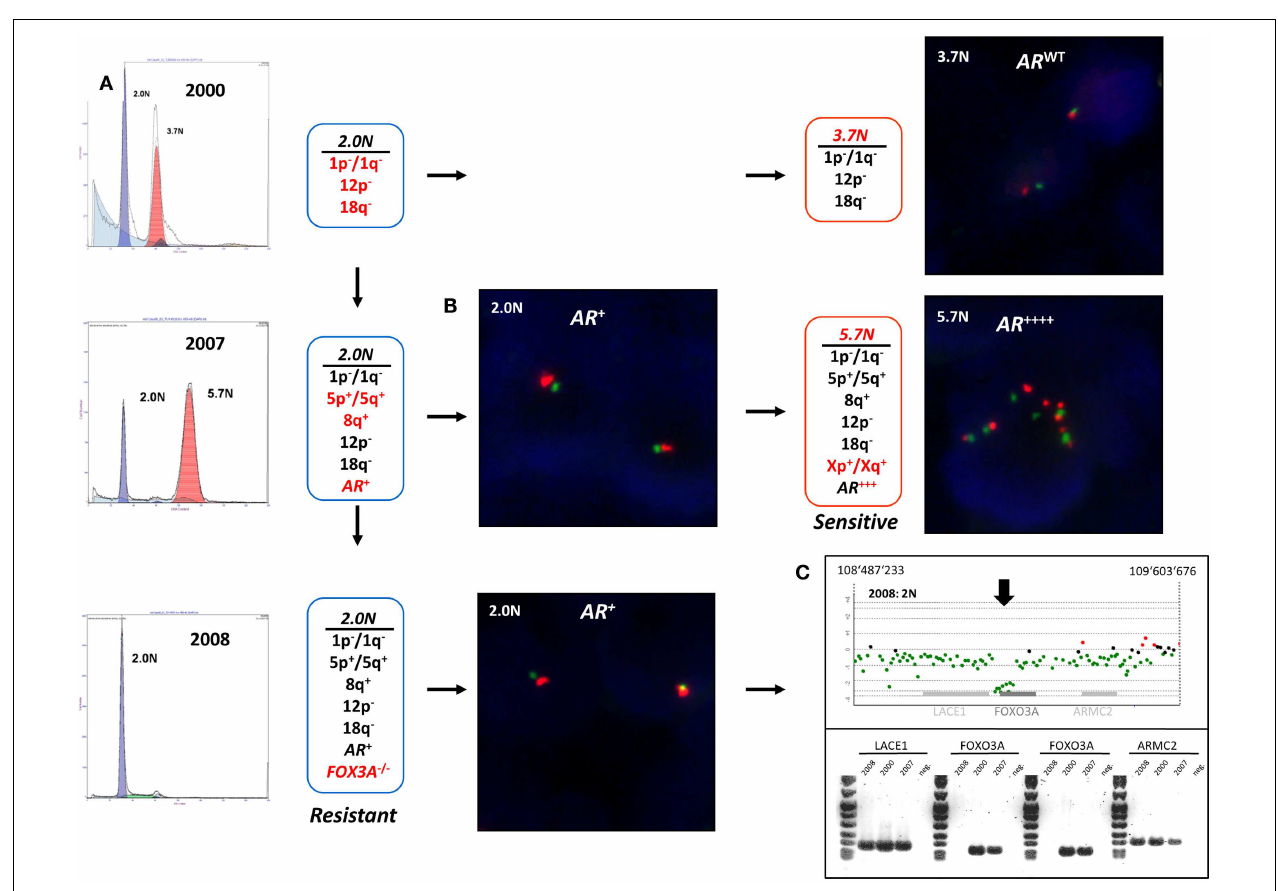
for each biopsy. Diploid (2.0N) and aneuploid populations arose in 2000 and evolved during clinical history of disease. (B) FISH analysis of chromosome X (green centromere; red AR locus) and validation of AR amplicons arising in 2006. (C) PCR validation of homozygous deletion of FOXO3A gene in 2.0N population that evolved after AR withdrawal therapy in